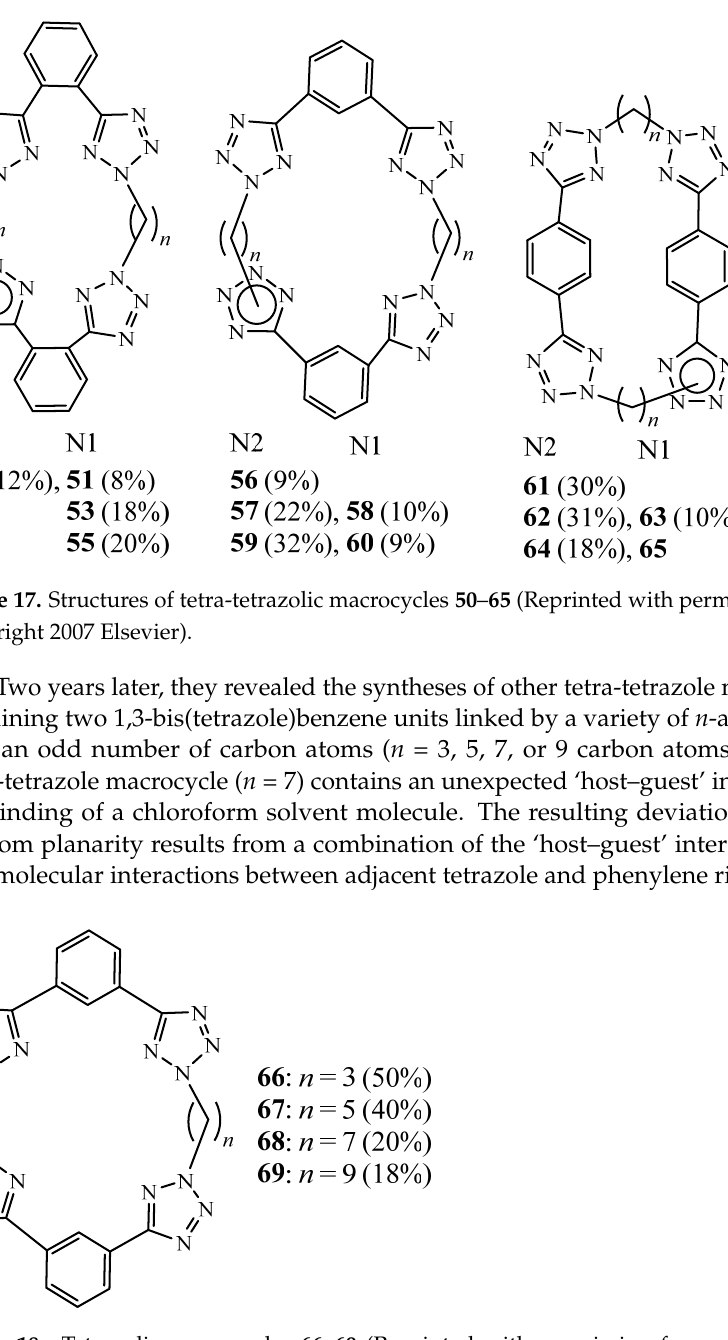
9 of 26 Figure 16. Copper complexes based on tetrazolic macrocycle 48. (Reprinted with permission from ref. [31]. Copyright 2017 American Chemical Societ). In 2007, Bond et al. described the syntheses of tetra-tetrazole macrocycles, containing two bis-tetrazole units 50 − 65 linked by a variety of alkyl chain lengths from 4–8 carbons